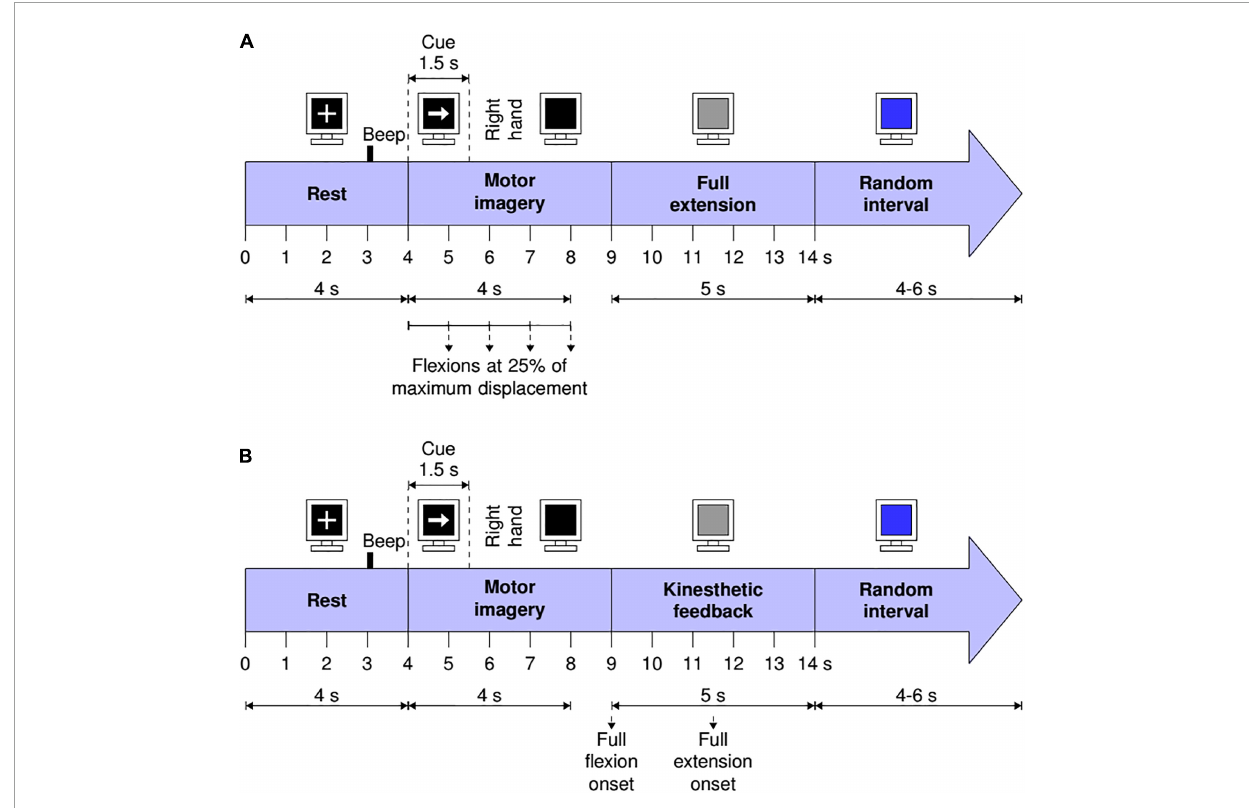
FIGURE2 Visual instructions and time structure of the trials with: (A) The continuous feedback and (B) The discrete